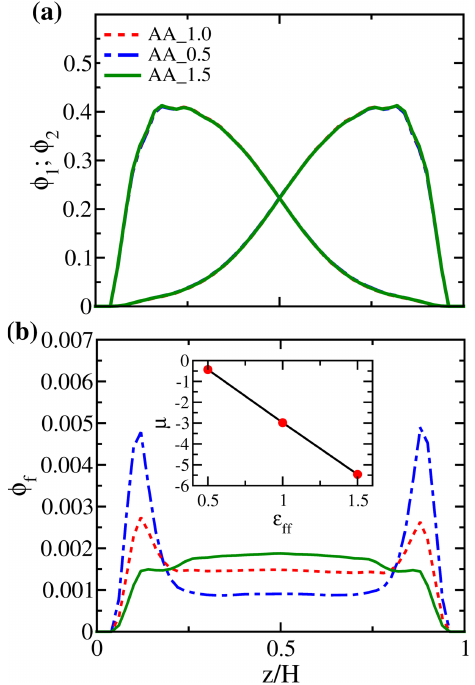
Figure 11. Local volume fraction distributions of ( a ) polymer beads and ( b ) free particles for systems AA_0.5, AA_1.0, and AA_1.5 at fixed N f = 400. The inset in ( b ) shows the variation in chemical potential ( µ ) for free particles in system AA as a function of ε f f